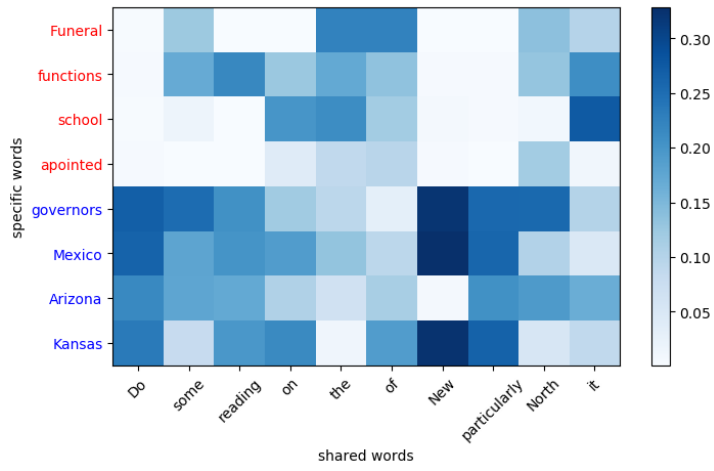
Figure 11. Graph edge weights